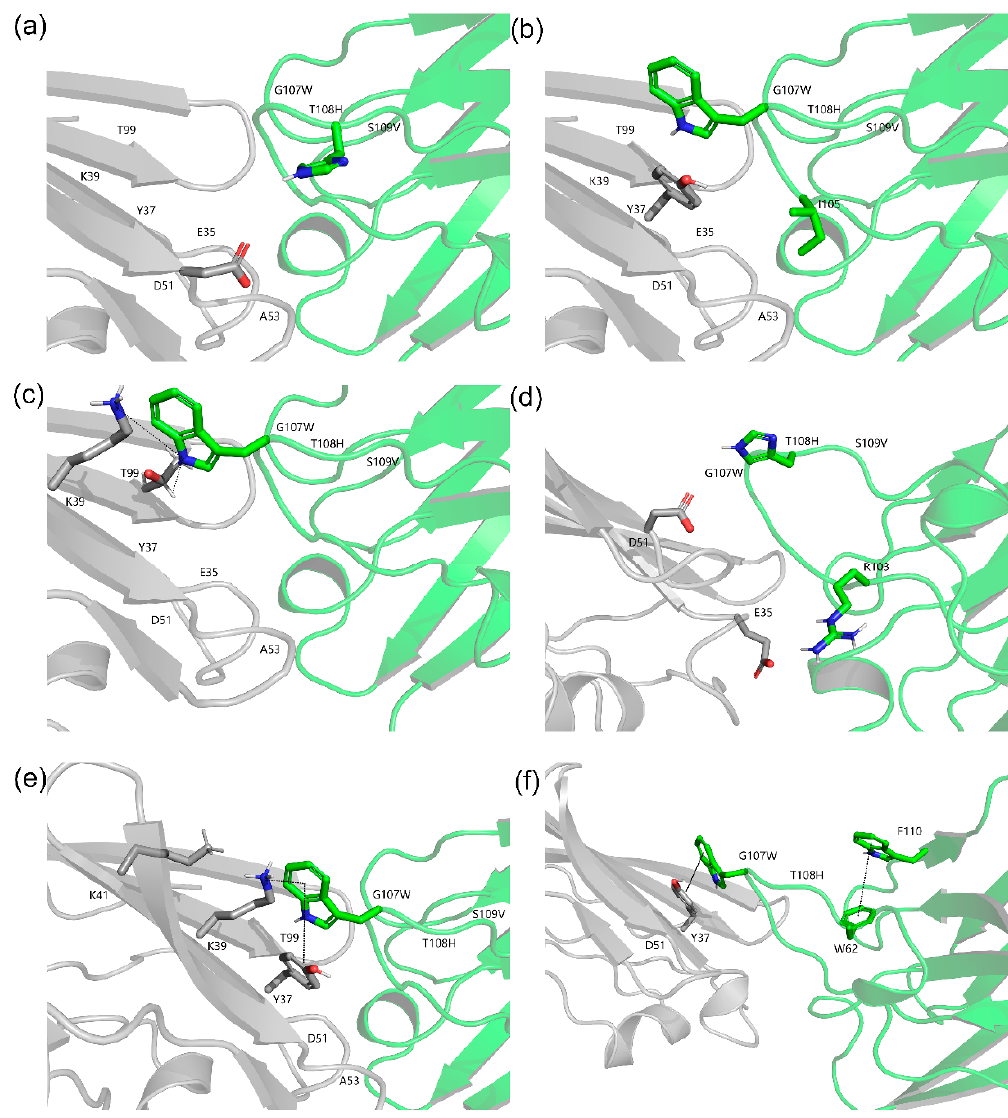
Figure 8. Structure models of optimized CD47 ext -VHH interactions. The VHH and CD47 ext chains are colored green and grey, respectively. The corresponding C atoms are colored blue and H atoms colored red. ( a ) Structure model of the T108H. A salt bridge is formed between T108H and 51D of CD47 ext . ( b ) Structure model of the G107W. Hydrophobic interactions are created between G107W and 37Y of CD47 ext . ( c ) Hydrogen bonds formed by G107W. H-bonds are shown in black and dashed lines. ( d ) Ionic interactions built by T108H. ( e ) Cation-Pi interaction (G107W-39K / 41K) and Aromatic-Aromatic interaction (G107W-37Y). ( f ) Aromatic-Aromatic interaction of F110 and G107W.